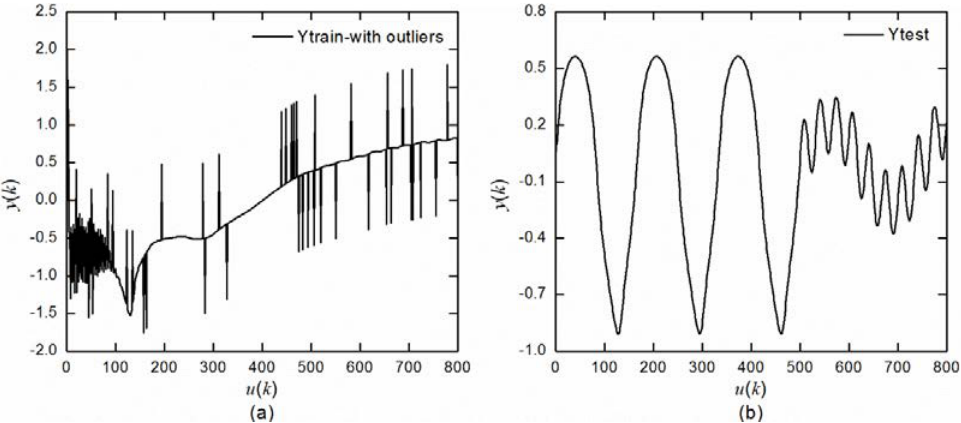
Figure 5. ( a ) The target output with noise and outliers in the training stage and ( b ) the target output in the test stage.